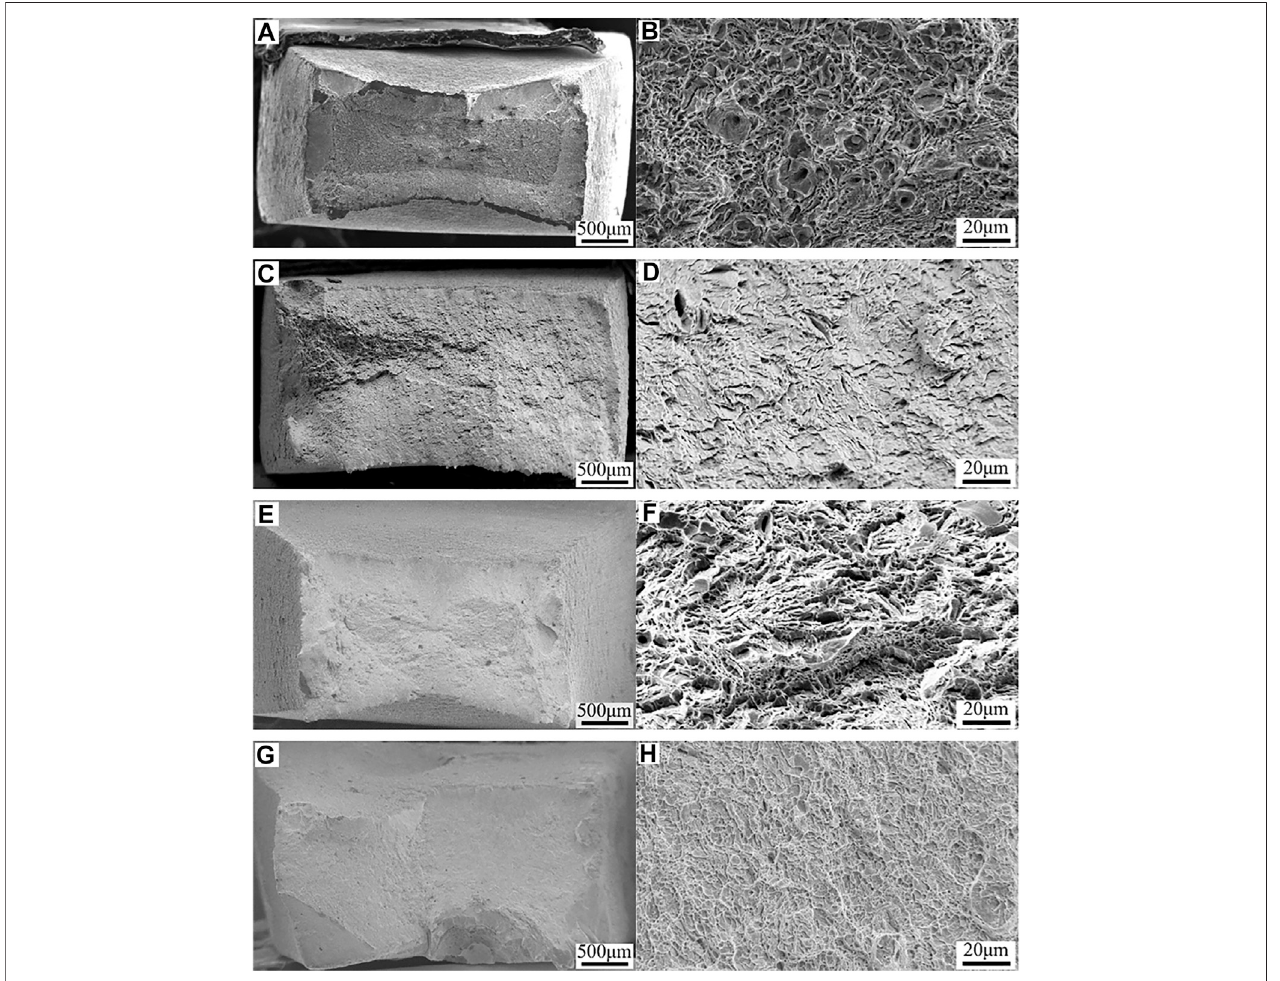
FIGURE7 | Fracture morphologies ofHP-13Cr SSviewedfrom the top after SSRTin FWat 95 ° C/2.8 MPa CO 2 withoutLA immersion at (A) lowmagni fi cation and (B) highmagni fi cation,afterLAimmersionat (C) lowmagni fi cationand (D) highmagni fi cationand120 ° C/3.2MPaCO 2 withoutLAimmersionat (E) lowmagni fi cationand (F) high magni fi cation, after LA immersion (G) low magni fi cation and (H) high magni fi cation.